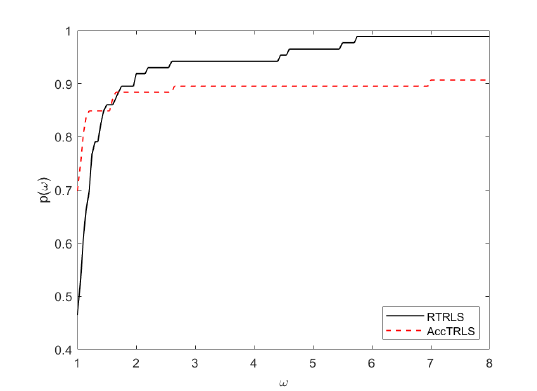
Figure 1. Number of iterations per- formance profiles